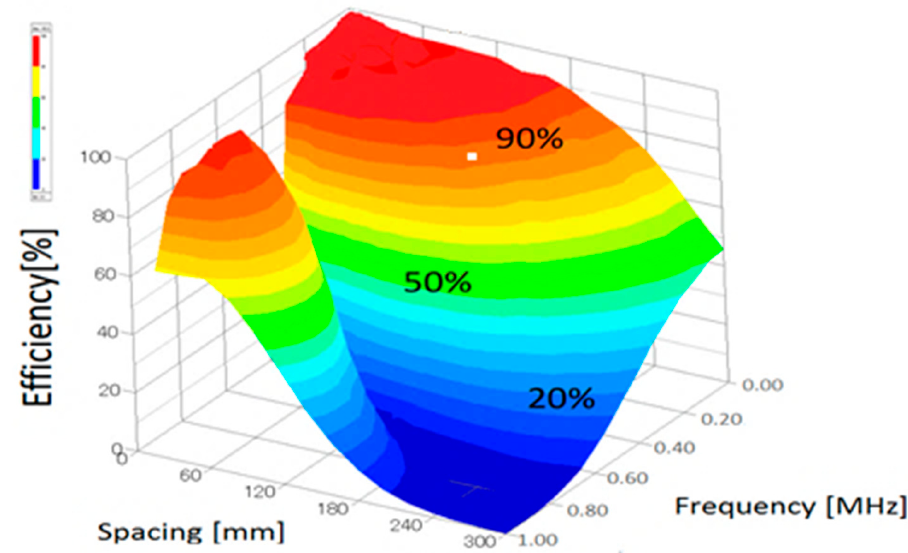
Figure 8. Three-dimensional quadrilateral graph of efficiency, spacing and frequency.